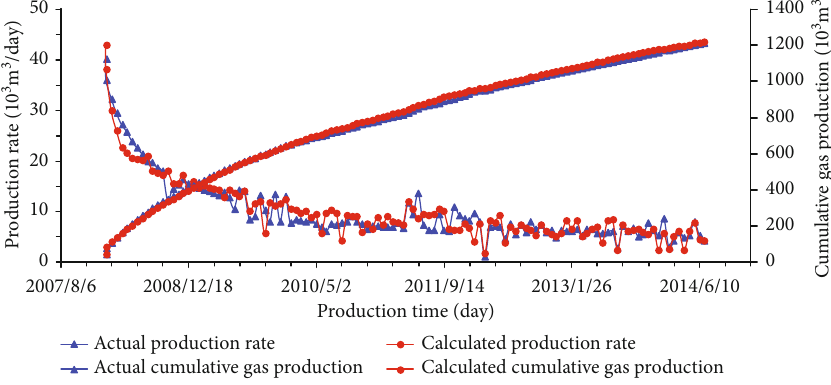
Figure 10: Single well pressure fi